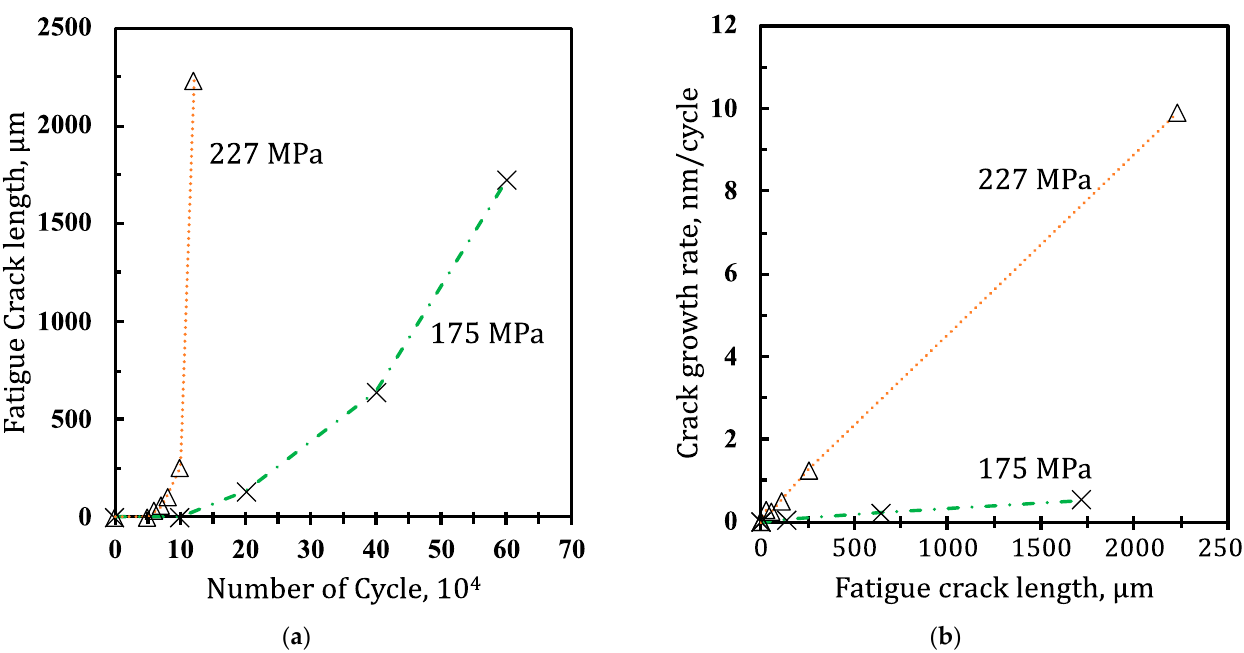
Figure 5. ( a ) Relationship between fatigue crack length and number of cycles; ( b ) Crack growth rate with respect to fatigue crack length.